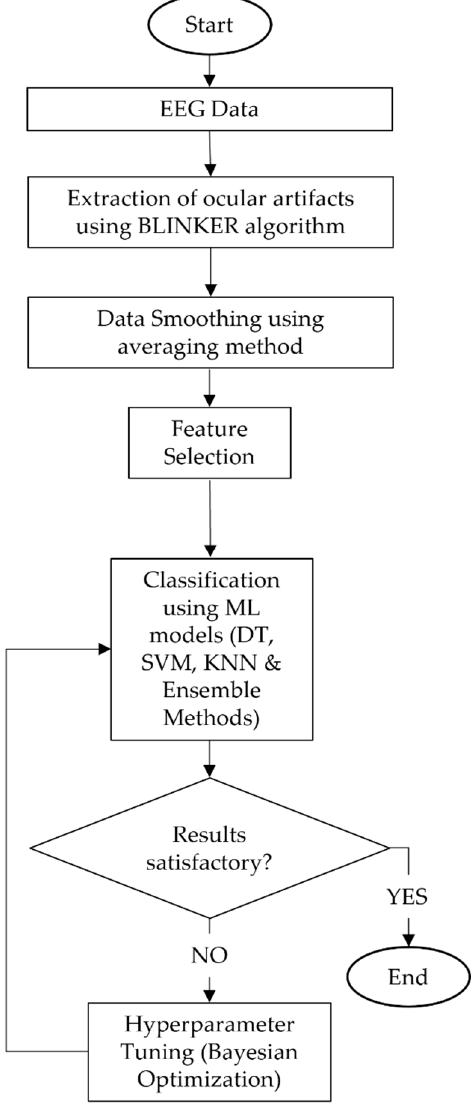
Figure 1. Flowchart of the research methodology.